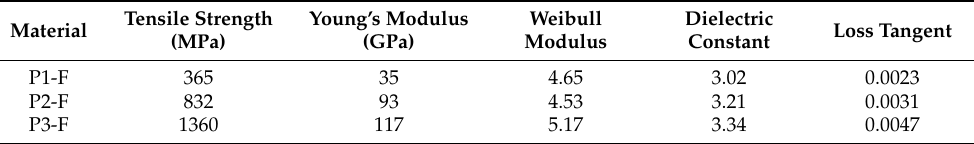
Table 4. Tensile strength, Young’s modulus and dielectric properties (f = 10 GHz) of BN/Si 3 N 4 composite